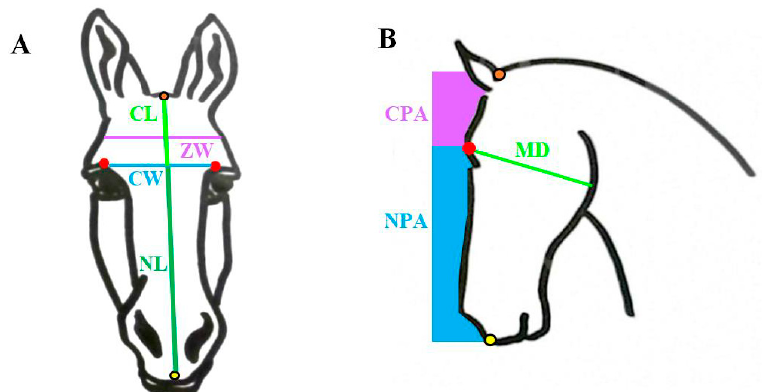
Figure 1. Diagram of the various measurements taken from horse ( n = 14) and donkey ( n = 16) skulls. The orbital notch is marked by the red dot. The occipital crest is marked by the orange dot, and the incisive bone is marked by the yellow dot. ( A ): The frontonasal suture line is estimated by a horizontal line joining the left and right orbital notches to determine cranial width = CW blue line. Cranial length = CL light green line; nasal length = NL dark green line; zygomatic width = ZW purple line. ( B ): mandibular depth = MD green line, nasal profile area = NPA blue area, cranial profile area = CPA purple area. See text for details of each measure.